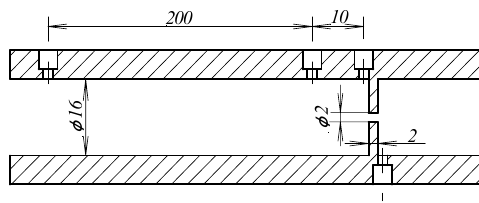
Fig.1 Pipe with test orifice and four pressure taps